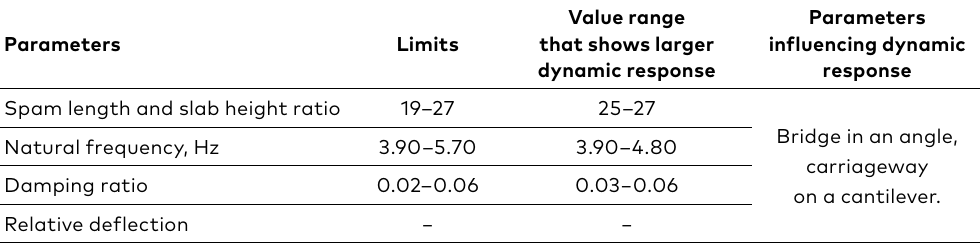
Table 4. Values which indicate increased dynamic reaction for pre-stressed ribbed slab